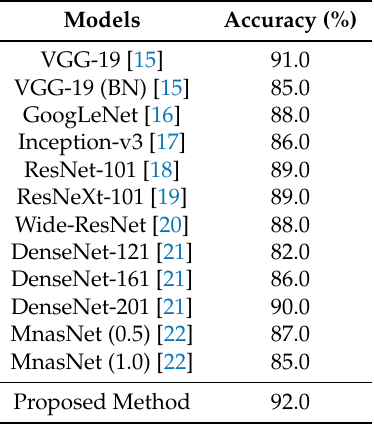
Table 3. Performance comparison with the existing CNNs using COCO-Stuff test set.